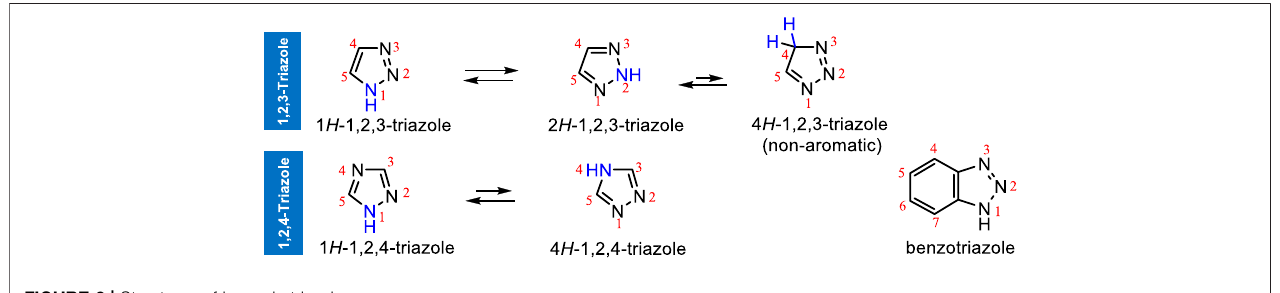
FIGURE 2 | Structures of isomeric